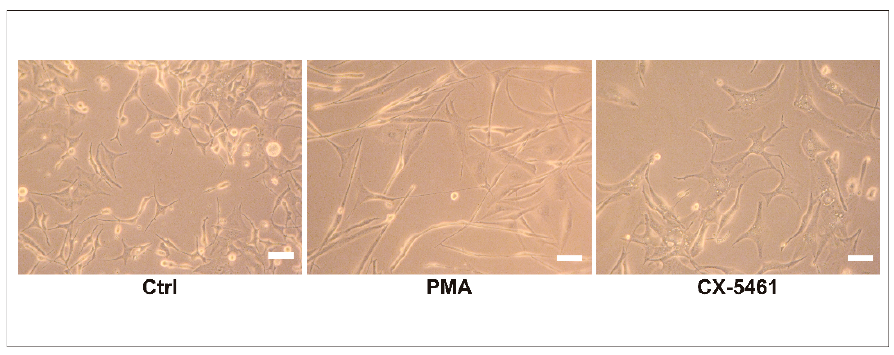
Figure 1. Morphology of MO3.13 cells. Representative images of control cells (Ctrl) and those treated with PMA or CX-5461 taken on the 6th day of treatment. Scale bar is 20 µm.